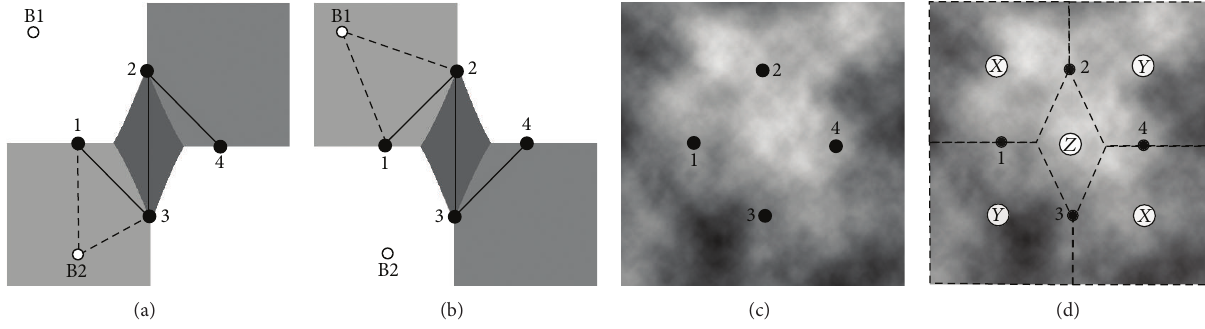
Figure 5: (a) and (b) A simple example of Algorithm 2 application; inequality 𝑝( B 2) > 𝑝( B 1) gives impetus to prefer the tour (1,3,2,4) to (1,2,3,4) (in spite of their equal cost) because the first one remains optimal in case of possible insertion of “important” B 2 ; (c) and (d) an example of nontrivial function 𝑝 ; the brightness of the pixels on the canvas 𝑋 = 1, 400 × 1, 400 corresponds to the values of function 𝑝 (the darker pixel (𝑥, 𝑦) − the larger 𝑝(𝑥,𝑦) ); here tour (1,3,2,4) is still preferable, because area 𝑌 exceeds area 𝑋 in “summary